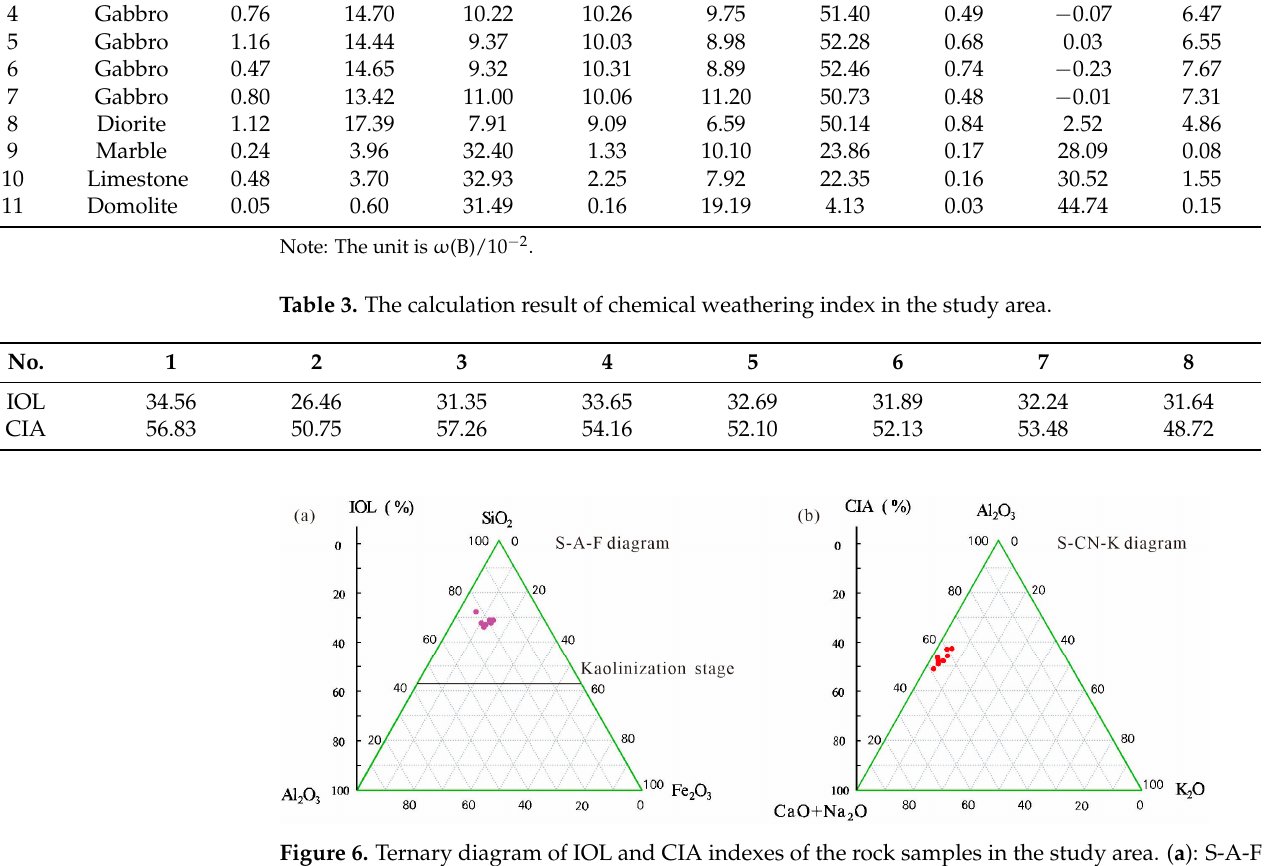
Figure 6. Ternary diagram of IOL and CIA indexes of the rock samples in the study area. ( a ): S-A-F diagram; ( b ): A-CN-K diagram.